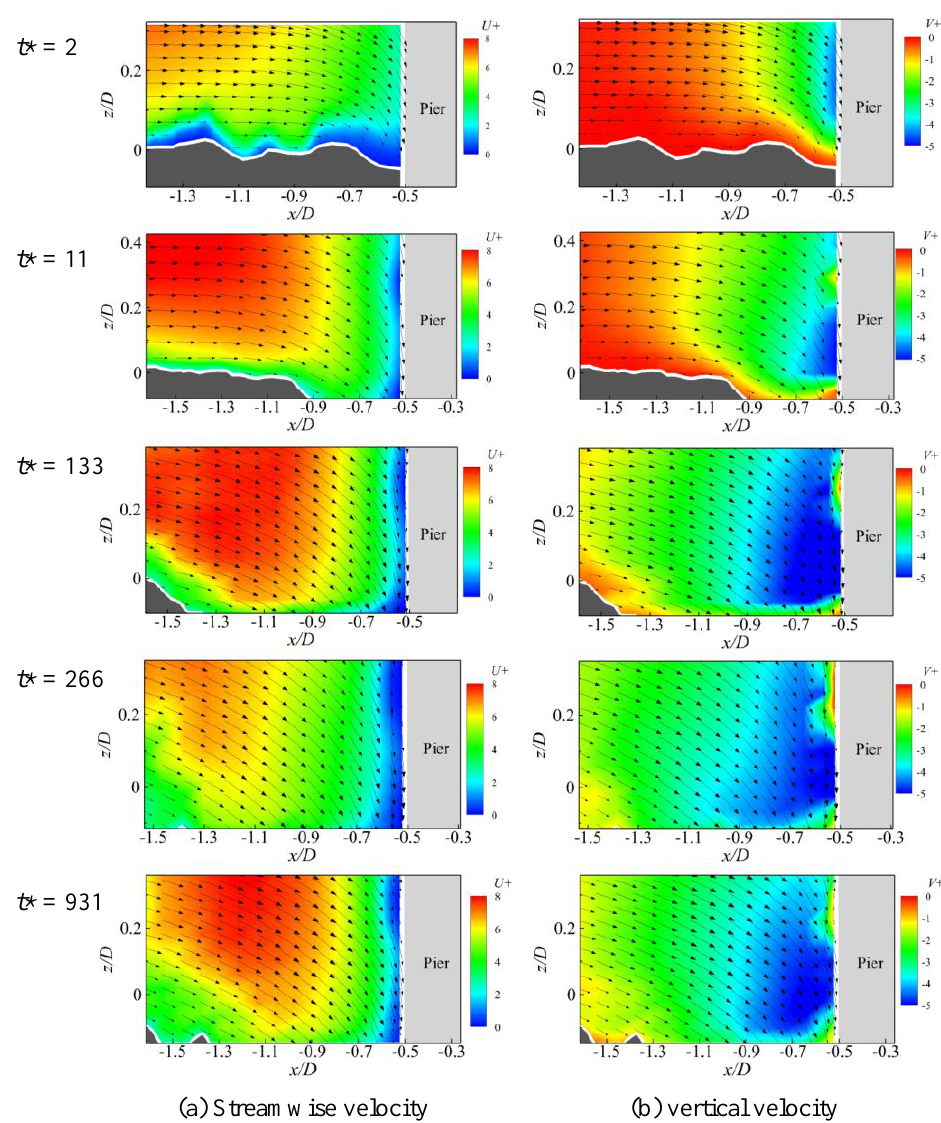
ff erent time in the pier scouring